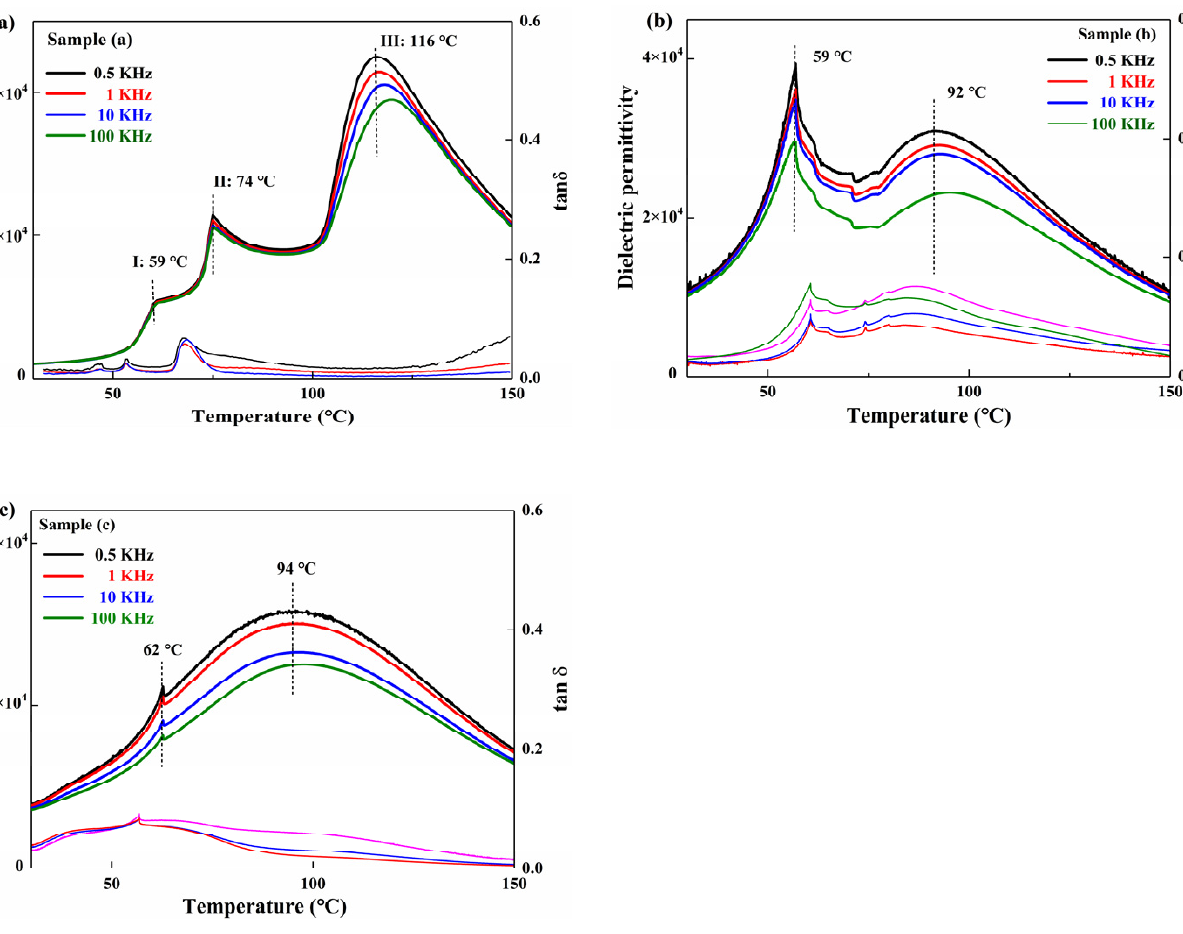
Figure 3. The temperature dependence of dielectric permittivity and dielectric loss tan δ for the crystal wafers fabricated from the different crystal samples ( a ), ( b ), and ( c ).